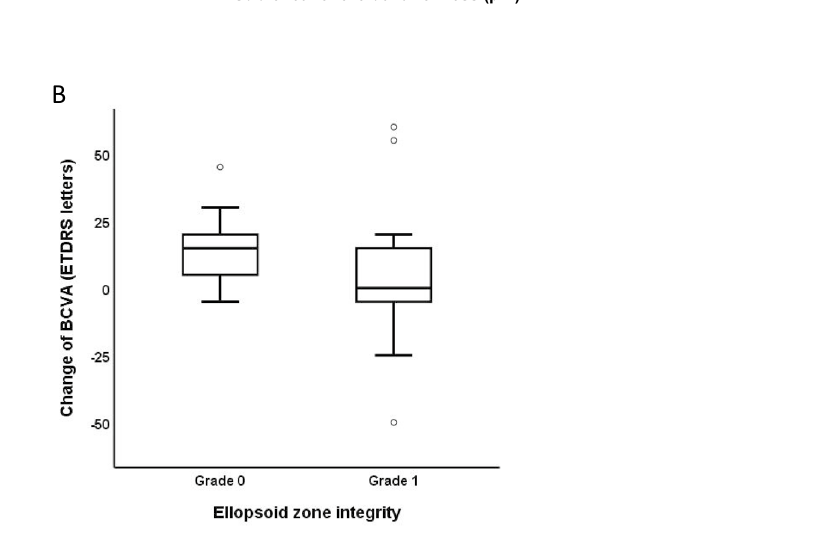
Figure 2. Analysis of the association between change in best-corrected visual acuity (BCVA) with subfoveal choroidal thickness (SFCT) and comparison change in BCVA with ellipsoid zone integrity. ( A ) The figure shows the linear regression and association analysis of SFCT with change in BCVA between baseline and 12 months (P = 0.002, r = 0.515). Dashed line represents the regression line. ( B ) Box plots of change in BCVA with ellipsoid zone integrity are shown. Quantitative analysis shows that there is significant difference in the grading of ellipsoid zone integrity (P =